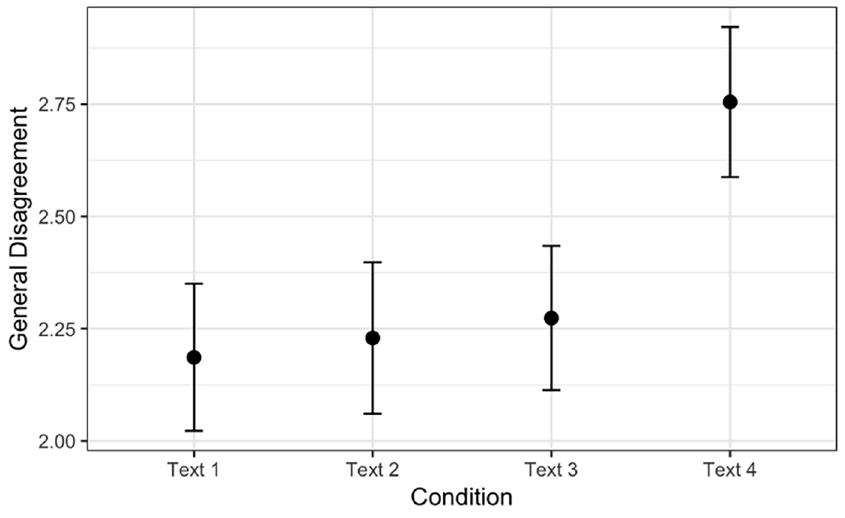
Figure 3. The effect of condition on general disagreement. Note. Error bars represent SE